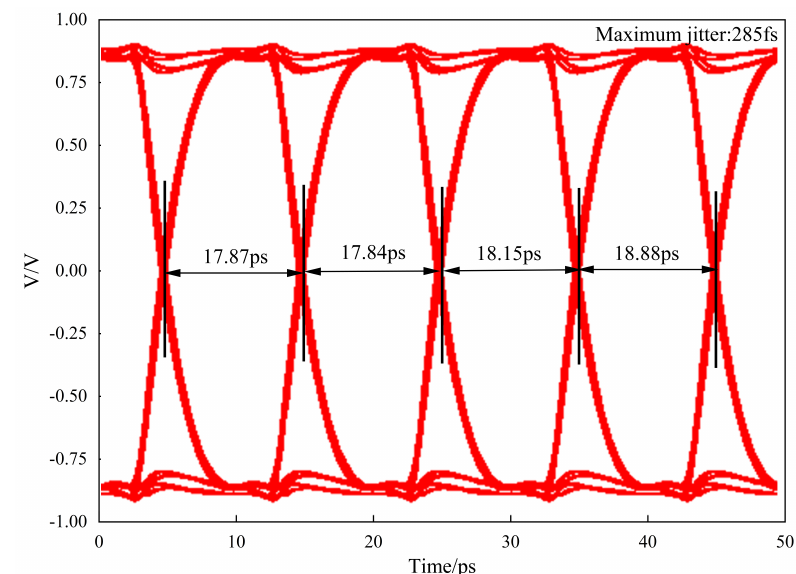
Figure 11. The 4:1 MUX differential output eye diagram.